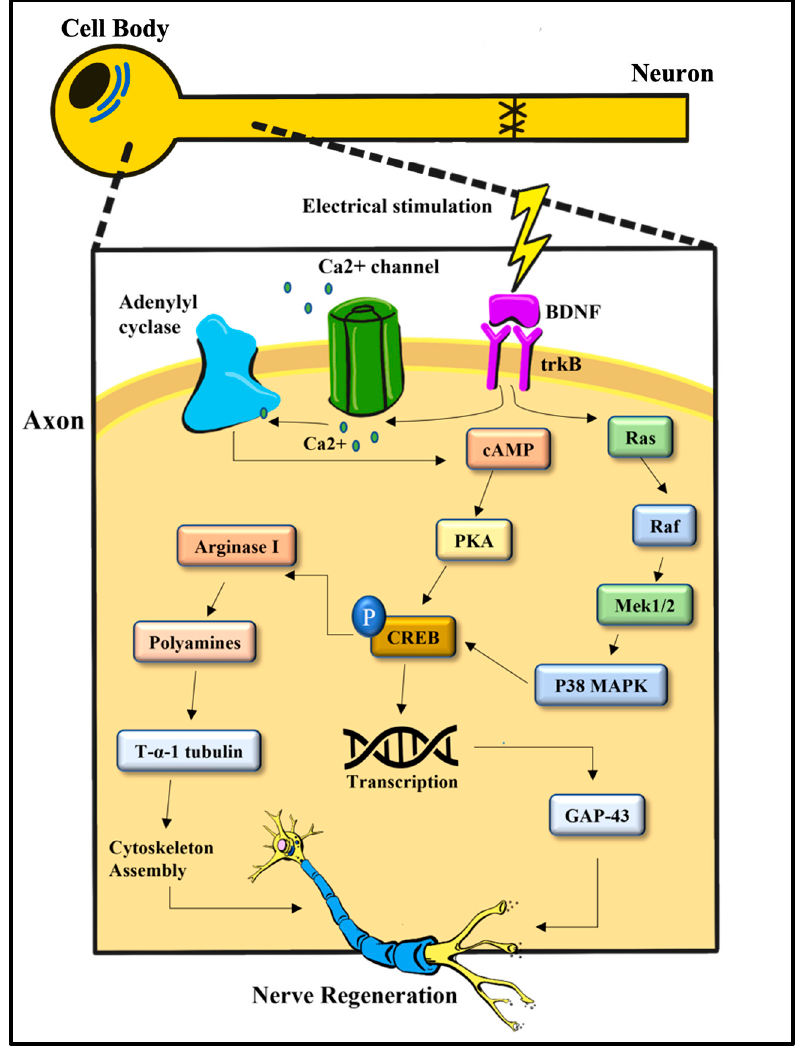
Figure 2. Electrical stimulation proximal to the injury site stimulates the upregulation of RAG through a calcium-dependent mechanism. Increased expression of BDNF and trkB drives increased expression of cAMP which activates CREB to maximize the pro-regenerative axon phenotype, stimulating axonal sprouting and neuron survival. BDNF = brain derived neurotrophic factor; cAMP = cyclic adenosine monophosphate; CREB = cAMP response element binding protein; trkB = tyrosine receptor kinase B; pKA = phosphokinase A; GAP-43 = growth-associated protein; MAPK = mitogen-activated protein kinase. Adapted from Zuo, K. J., Gordon, T., Chan, K. M., & Borschel, G. H. (2020). Electrical stimulation to enhance peripheral nerve regeneration: Update in molecular investigations and clinical translation. Experimental Neurology, 332,